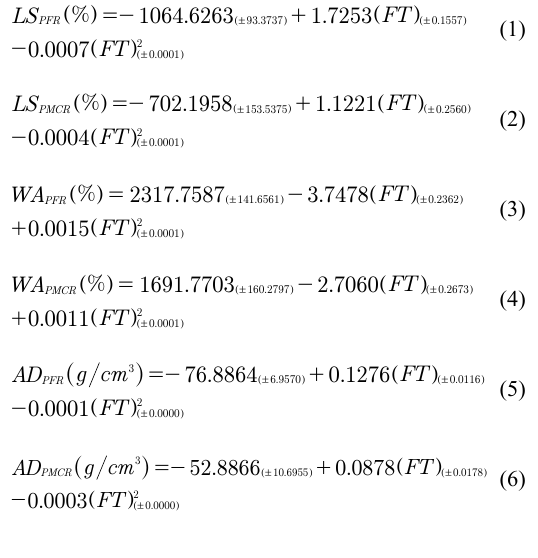
Table 4 lists the values of the dependent variables: linear shrinkage (LS), water absorption (WA), apparent density (AD) and 3-point flexural strength (FS) of porcelain specimens containing fine quartzite residue (PFR) and milled coarse quartzite residue (PMCR). All of them were prepared according to the experimental planning matrix, obtained with the aid of the software Statistica 7.0 . With the results observed for LS, WA, AD and FS, it was possible to obtain regression equations correlating these dependent variables with the firing temperature (FT) factor. In order to build the mathematical models, only the factors that had statistically significant effects on the studied variables, at the level of 95% confidence, were considered. Therefore, the residue content (RC) factor was not added in the equations since it did not present statistically significant effects. The mathematical models are presented by Equations (1) to (8).